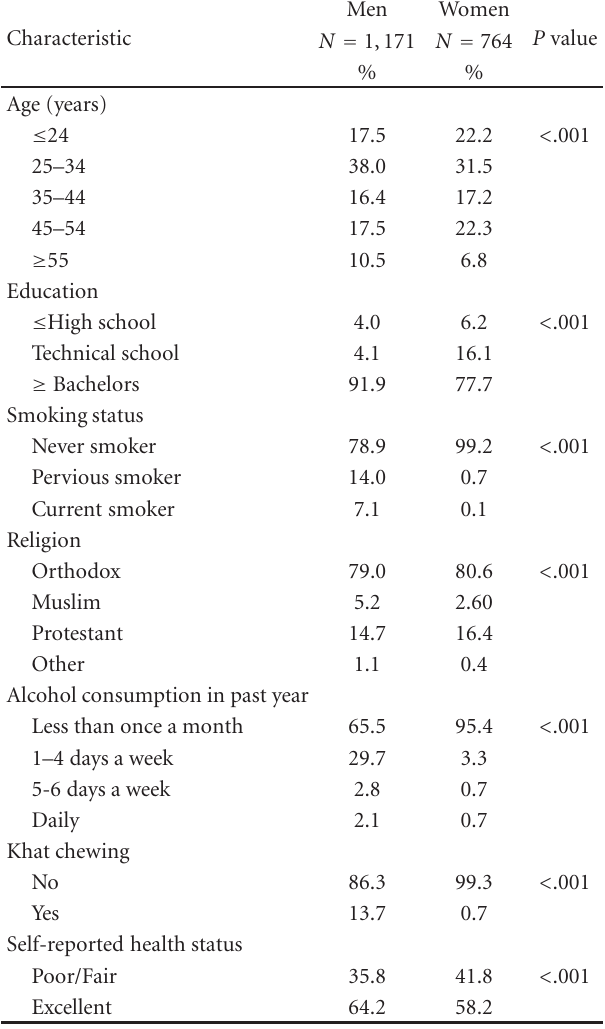
Table 1: Sociodemographic characteristics of the study population.